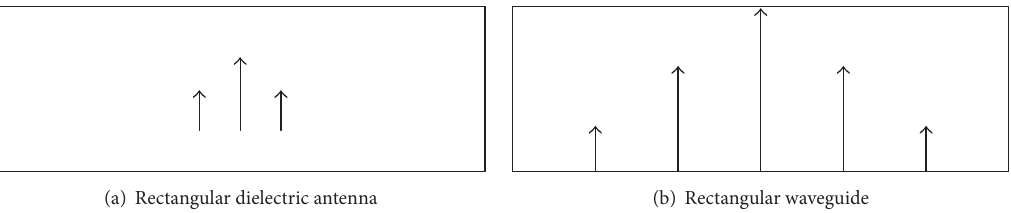
Figure 12: Dominant modal electric field profiles (a) in rectangular dielectric and (b) in rectangular waveguide.